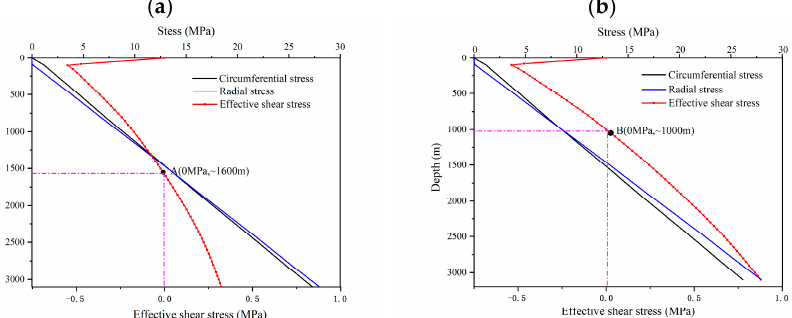
Figure 5. Variation in stress in the borehole wall, with depth (( a ): for σ H direction; ( b ): for σ h direction).